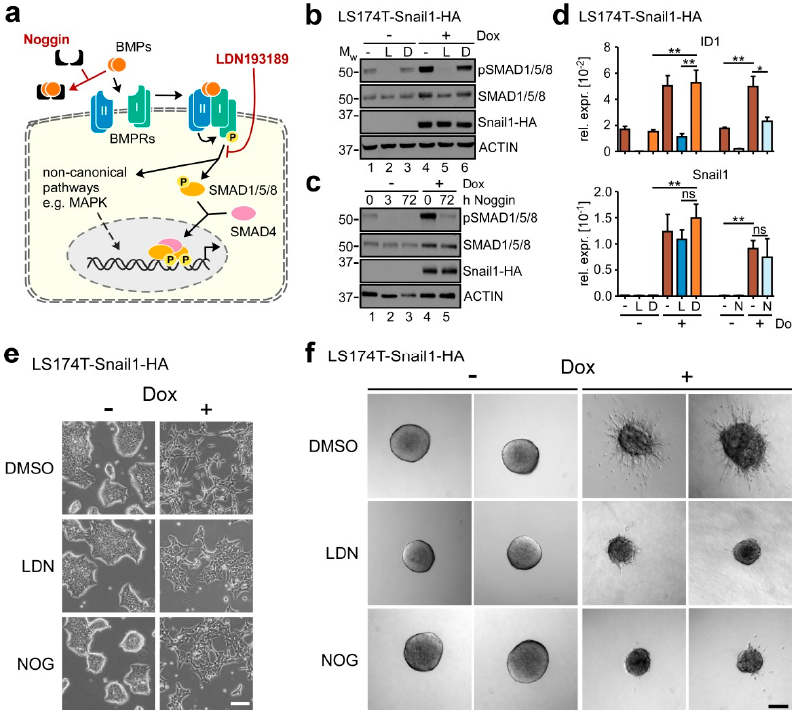
Figure 2. Inhibition of the BMP pathway strongly impairs the SNAIL1-induced EMT in colorectal cancer cells. ( a ) Schematic depiction of the BMP signaling pathway. The two inhibitors Noggin and LDN193189 interfere with signal transduction by sequestering BMP ligands and inhibiting BMP type I receptor A (ALK3), respectively. ( b ) Western blot analyses of whole-cell lysates. Names of detected proteins are indicated on the right. Cells were left uninduced or were treated with 0.1 µg·mL − 1 Dox and 50 nM LDN193189 (L), or DMSO (D) for 72 h. Positions of molecular weight (M W ) standards in kDa are given on the left. Detection of ACTIN was used as control for equal loading. ( c ) Western Blot analyses of whole-cell lysates. Names of detected proteins are indicated on the right. Cells were left uninduced or were treated with 0.1 µg·mL − 1 Dox and 100 ng·mL − 1 Noggin for the indicated time spans. Positions of molecular weight (M W ) standards in kDa are given on the left. Detection of ACTIN was used as control for equal loading. ( d ) qRT-PCR analyses of mRNA expression in LS174T-Snail1-HA cells. Where indicated, cells were treated with 0.1 µg·mL − 1 Dox, 50 nM LDN193189 (L), DMSO (D), or 100 ng·mL − 1 Noggin (N) for 72 h. Shown is the mean+SEM; n = 3. Rel. expr.: relative expression normalized to that of GAPDH . ns: not significant. *: p < 0.05, **: p < 0.01. ( e ) Representative phase contrast images of LS174T-Snail1-HA cells treated with 0.1 µg·mL − 1 Dox and DMSO, 50 nM LDN193189 (LDN), or 100 ng·mL − 1 Noggin (NOG) for 72 h as indicated. Scale bar: 100 µm. ( f ) Spheroid invasion assay of LS174T-Snail1-HA cells treated with 0.1 µg·mL − 1 Dox and DMSO, 50 nM LDN193189 (LDN), or 100 ng·mL − 1 Noggin (NOG) for 96 h as indicated. Two representative spheroids are shown for each condition. Scale bar: 200 µm.